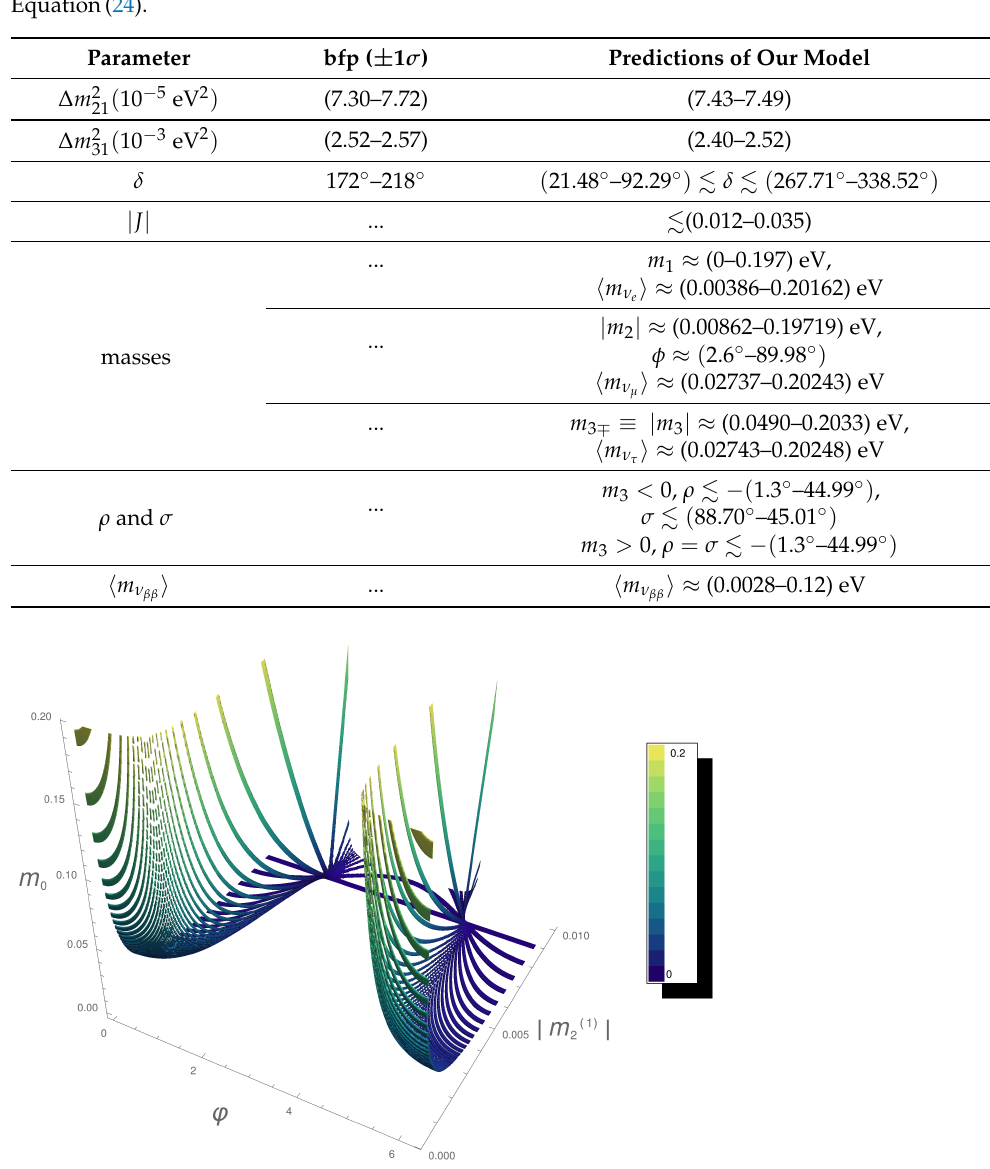
( 1 ) | - ϕ plane which is allowed by our model along Figure 2. In this figure, the whole region of the | m 2 with the allowed range of m 0 is shown. Each color curve implies a value of m 0 in the rang (0–0.197) eV ( 1 ) ( 1 ) | 2 + 2 m in the | m cos ϕ in our model. The overlap region of the experimental values for ∆ m 2 0 m 2 2 with our model are two tiny regions. These regions are the semi-symmetry of each